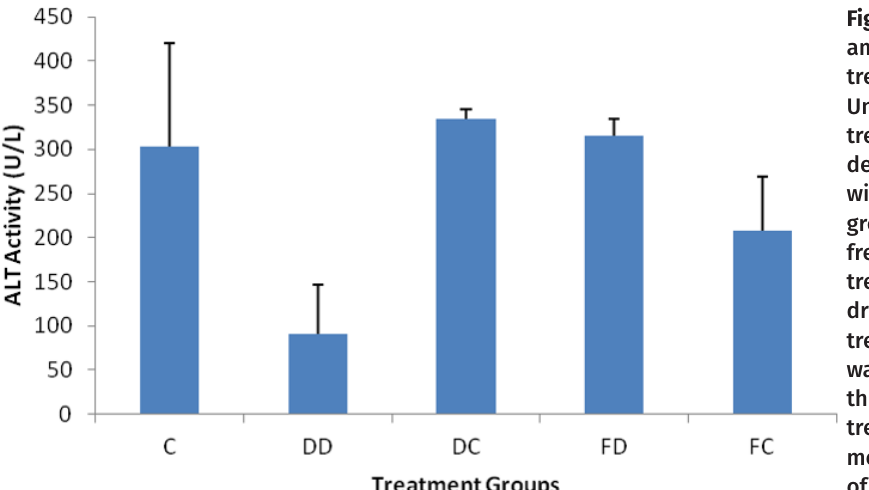
Figure 3. Alanine aminotransferase activity of treated and control mice in Units per Liter. DD = group treated with 30 mg/kg decoction; DC = group treated with 60 mg/kg decoction; FD = group treated with 30 mg/kg freeze-dried extract; FC = group treated with 60 mg/kg freeze- dried extract; C = control group treated with only distilled water. The values presented are the averages of the different treatment groups. Error bar means the standard deviation of the